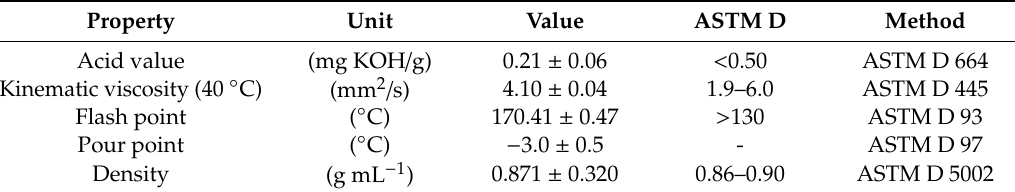
Table 3. Properties of WCO based biodiesel.